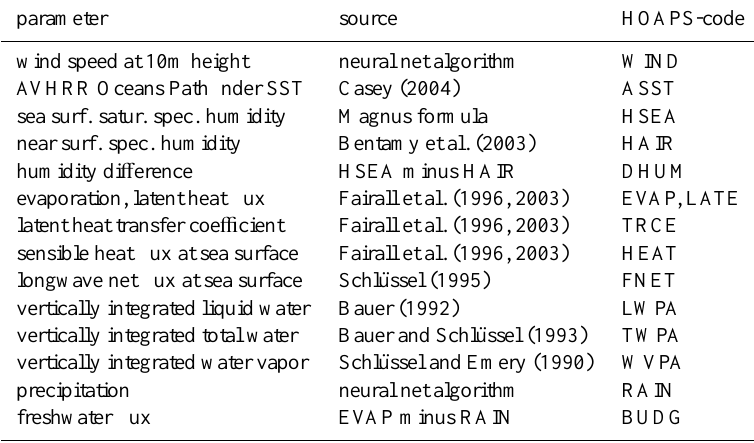
Table 2. Overview of HOAPS-3 parameters and algorithms. parameter source